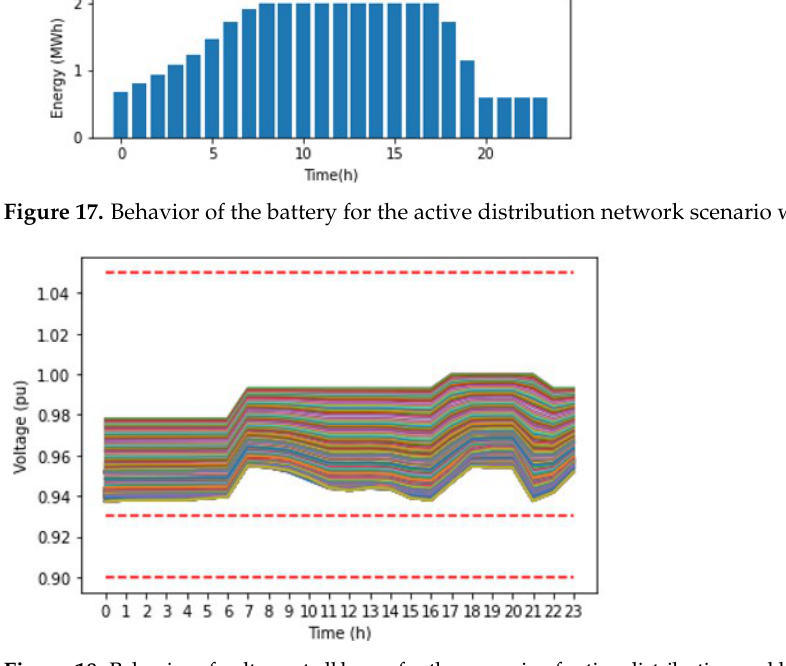
Figure 18. Behavior of voltage at all buses for the scenario of active distribution and load increase